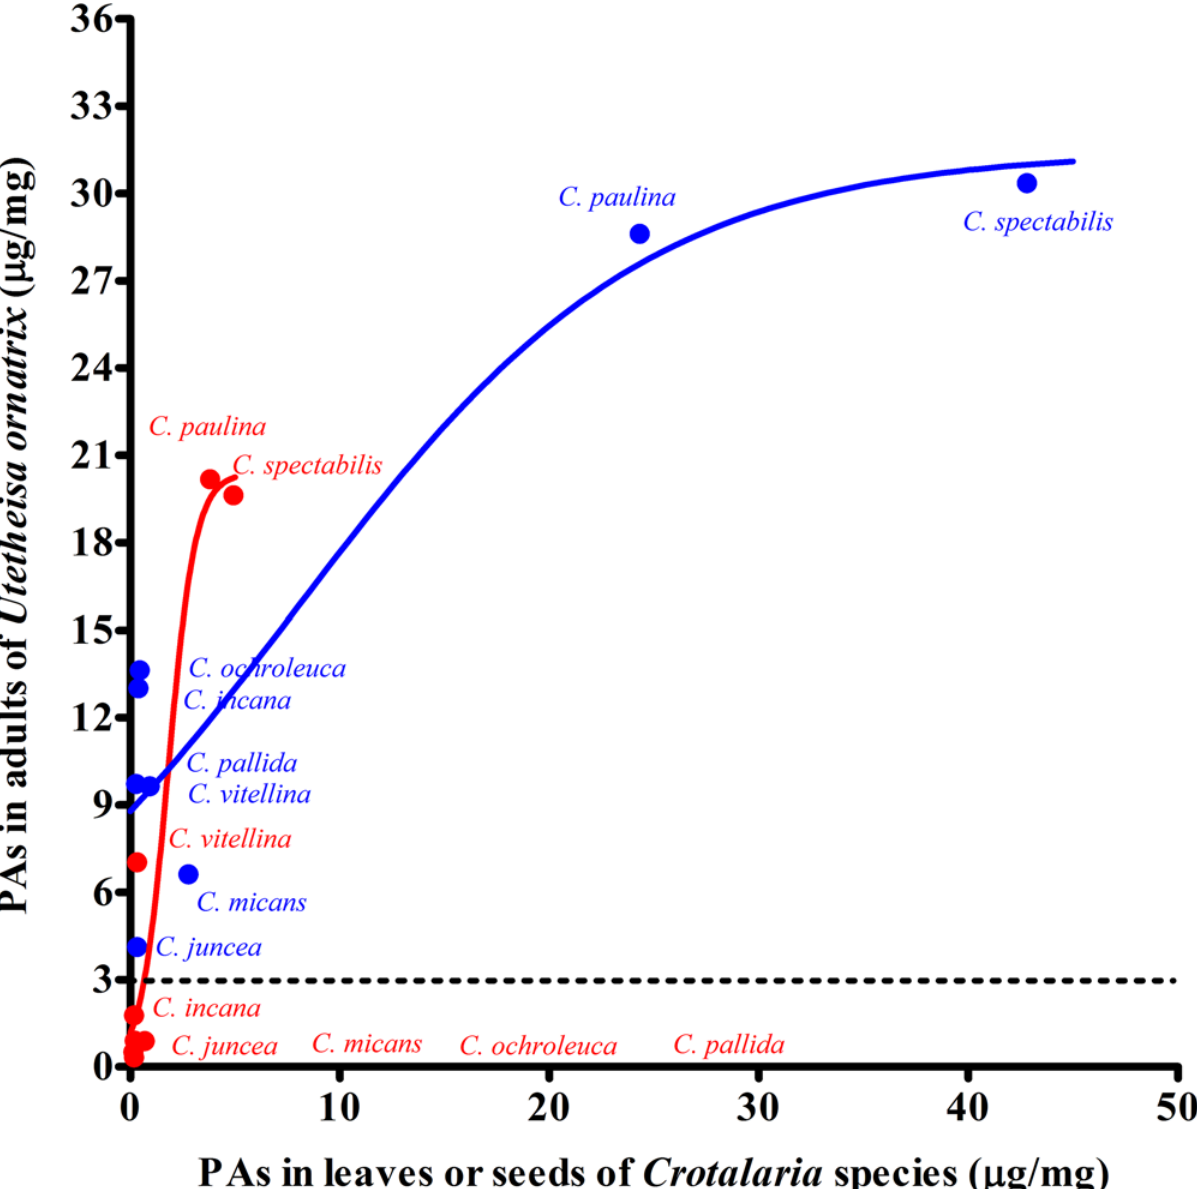
Fig 6. Non-linear relationship between the mean of pyrrolizidine alkaloid concentration ( μ g/mg dry weight) in Crotalaria species and in adults of Utetheisa ornatrix . Red symbols are leaves and blue are seeds. The dotted line is the concentration at which baits treated with monocrotaline and integerrimine in the N- oxide form (3.0 μ g/mg) were 100% released by Nephila clavipes